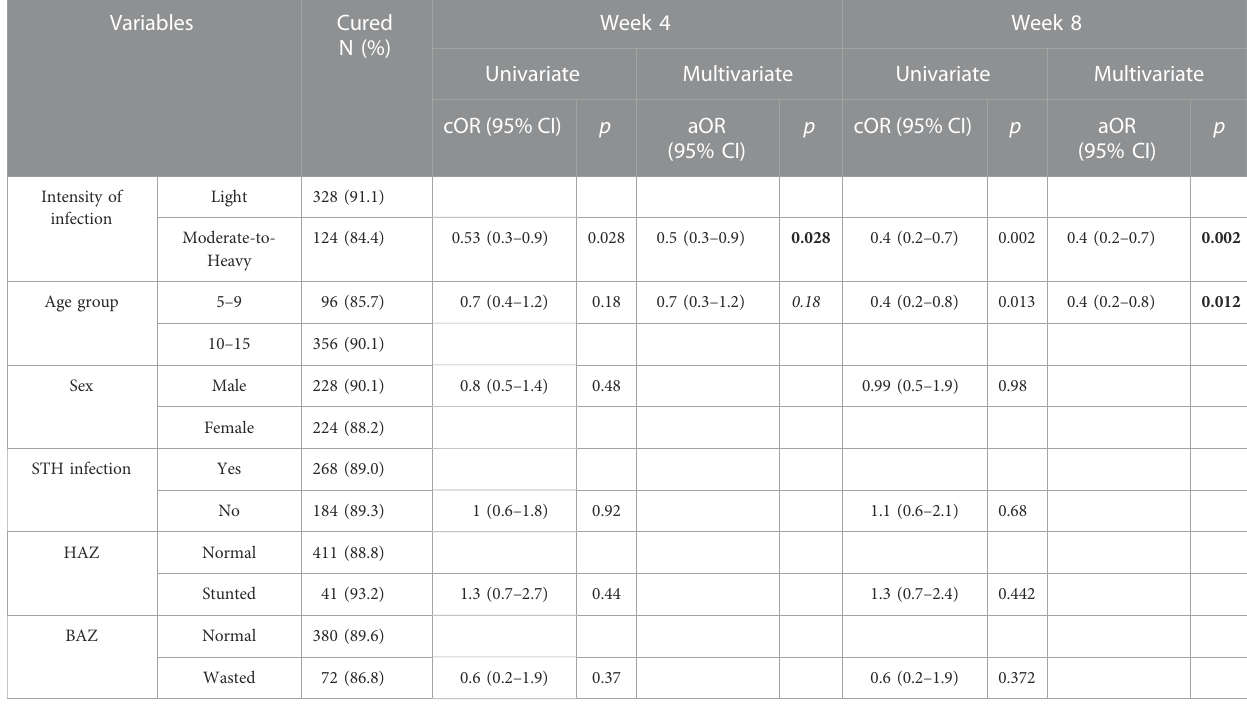
TABLE 3 Predictors of cure rate at weeks four and week eight of post single dose praziquantel administrations. Variables